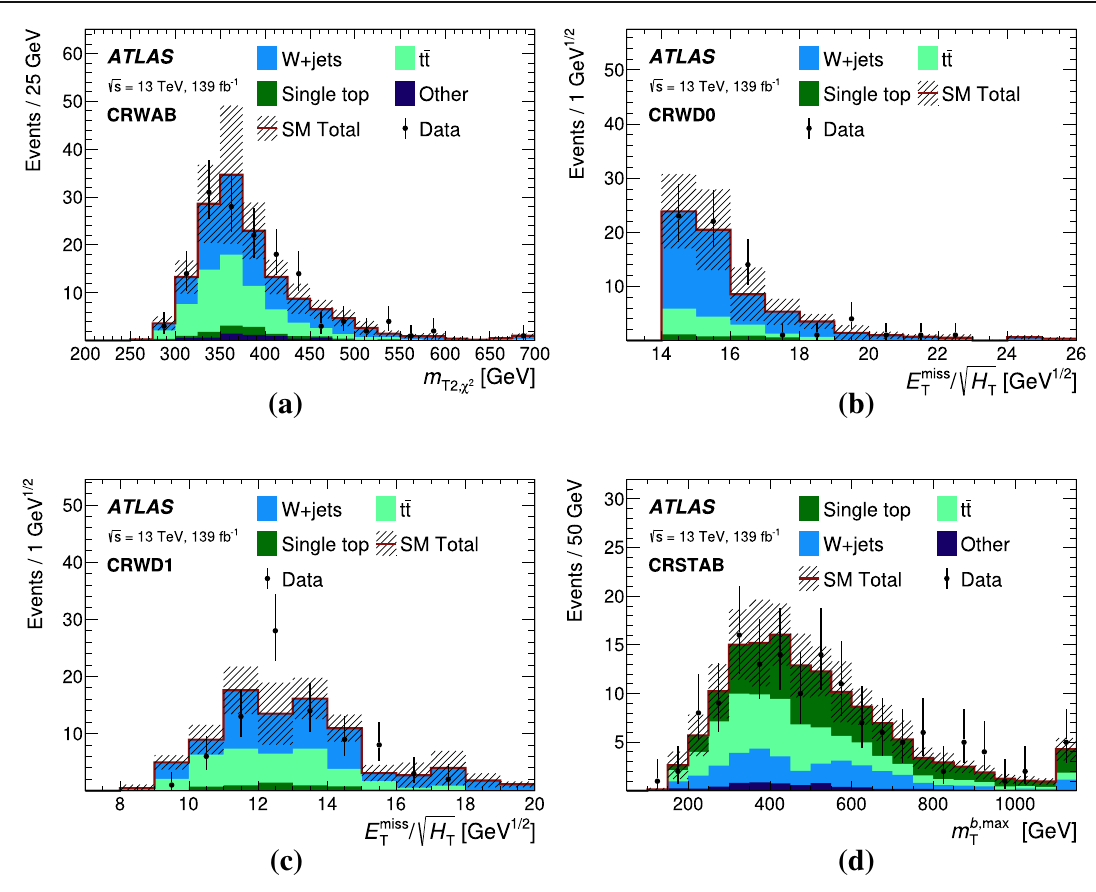
c CRWD1, and d m b , max for CRSTAB. The hatched uncertainty band T around the SM expectation includes the combination of MC statisti- cal, theory-related and detector-related systematic uncertainties. The √ / H T for b CRWD0 and rightmost bin in each plot includes all T